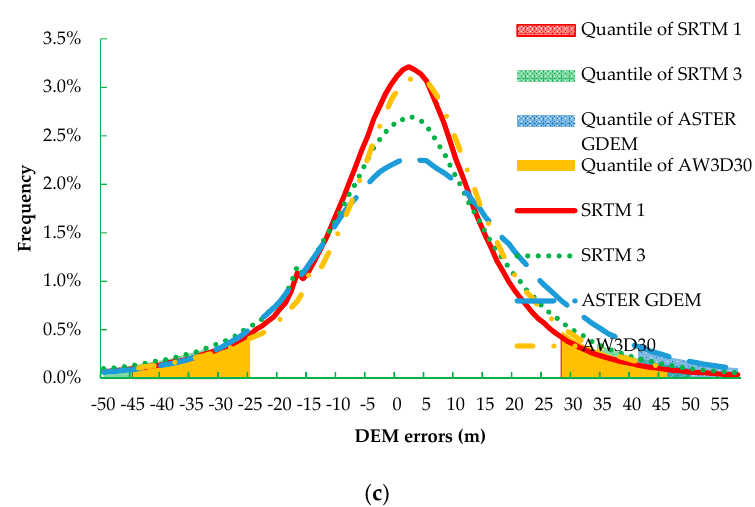
Figure 2. Frequency distribution of the DEM height errors for ( a ) plains, ( b ) hilly, and ( c ) mountainous areas. The 5% and 95% quantiles are represented by the shaded areas. The means and standard deviations are listed in Table 3. Table 3. Elevation accuracy (mean and standard deviation, in m) of the four DEMs in terms of terrain relief. Plain Hill Mountain DEM Mean Std. Mean Std. Mean Std.